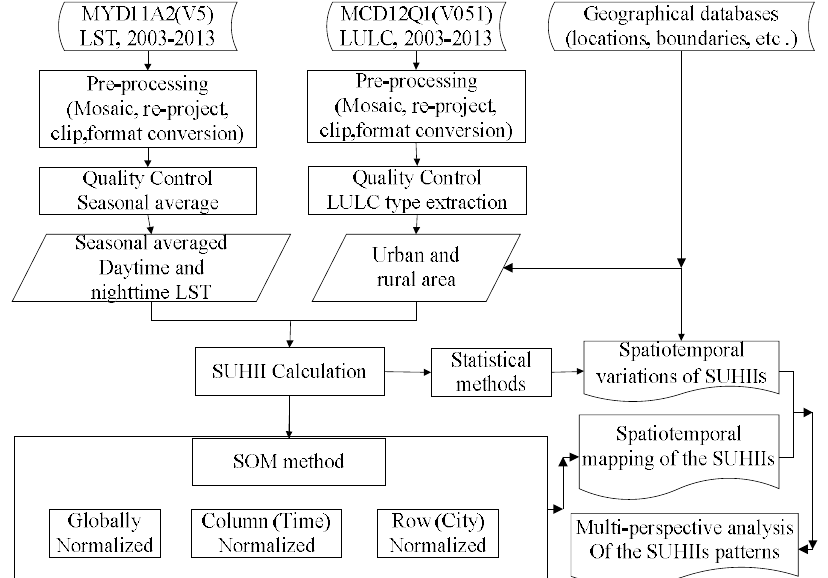
Figure 3. Flow chart in this research.